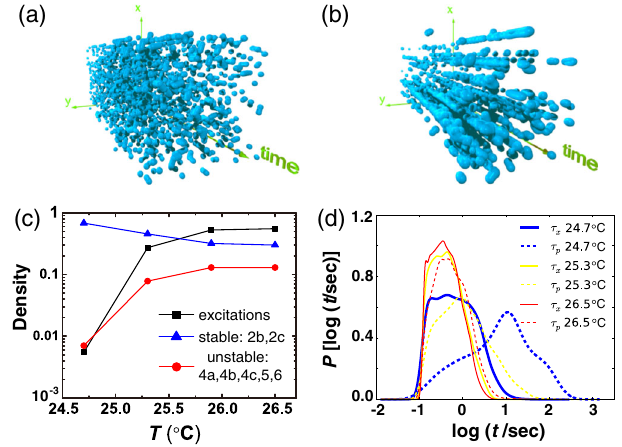
FIG. 6. Dynamic facilitation in the repulsive buckled crystal. (a),(b) Actively flipping regions labeled in blue in the ð 32 μ m Þ 2 × 4 s spacetime at 27 . 1 °C and ð 32 μ m Þ 2 × 200 s spacetime at 24 . 7 °C, respectively. The excitation coarse-graining time is 0.067 s in (a) and 0.33 s in (b). Different coarse-graining times yield similar spacetime structures, but shorter times make the structure too crowded to be clearly visualized. Excitations dispersed in spacetime at high T in (a) and coalesced into clusters at low T in (b). (c) Densities of the excitations, unstable, and stable motifs. (d) Probability distributions of τ